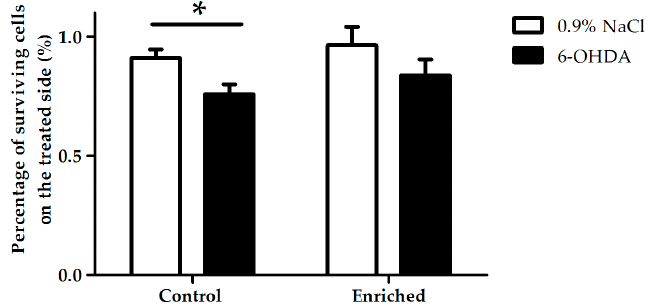
Figure 7. Percentage of TH-immunoreactive surviving cells on the treated side, compared to control side in saline (0.9% NaCl) and 6-OHDA-treated animals of control and enriched groups. Data are given as mean ± S.E.M., where 100% = 1.0. * p < 0.05 versus control 0.9% NaCl-treated group.